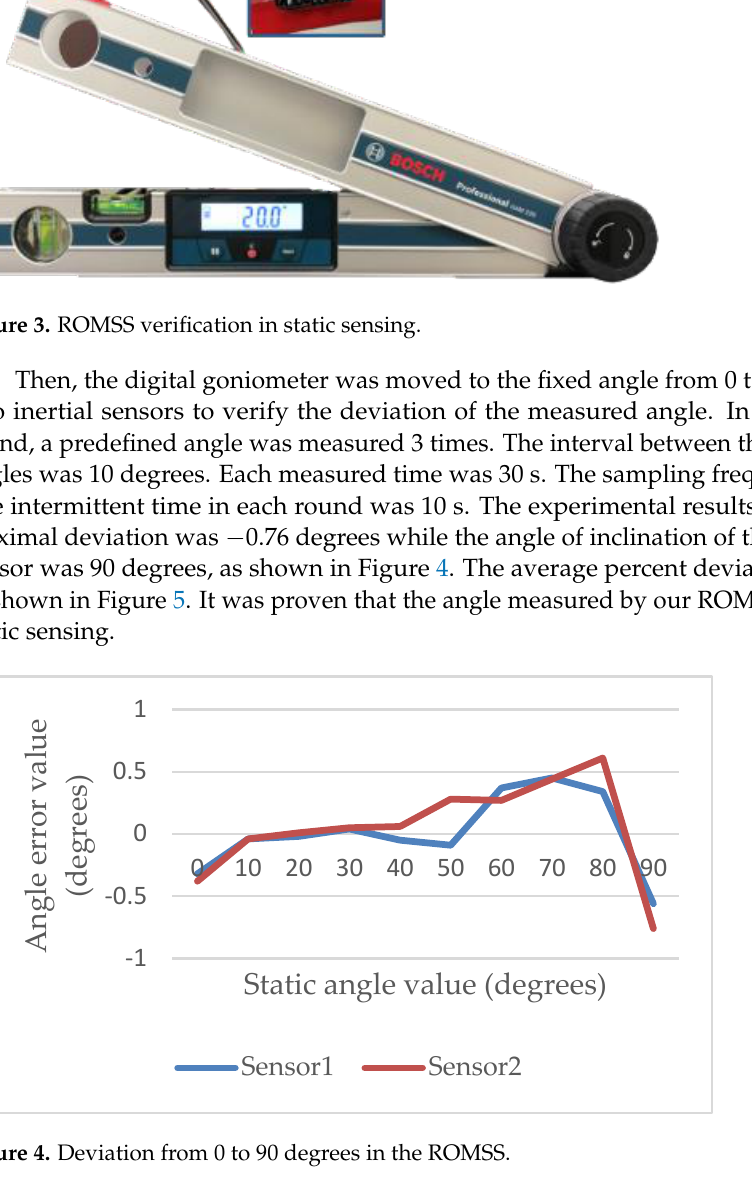
Figure 4. Deviation from 0 to 90 degrees in the ROMSS.